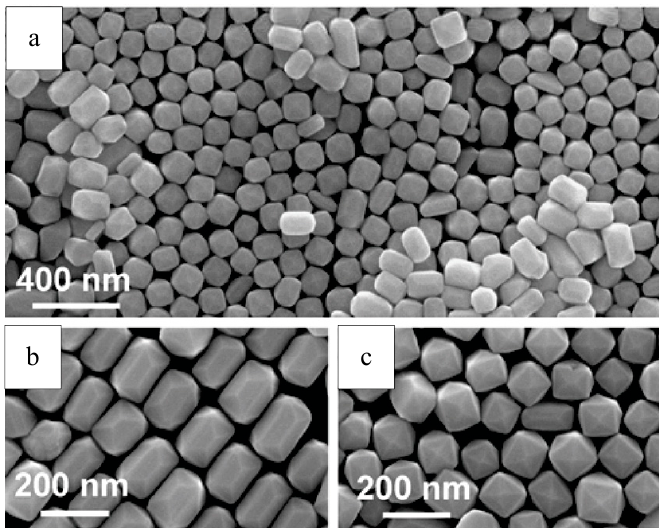
Figure 3. Large-area SEM image of the tetrahexahedral Au nanocrystals deposited on a Si substrate ( a ) and their side and end facets ( b , c ). Reproduced with permission [61]. Copyright 2009, American Chemical Society.